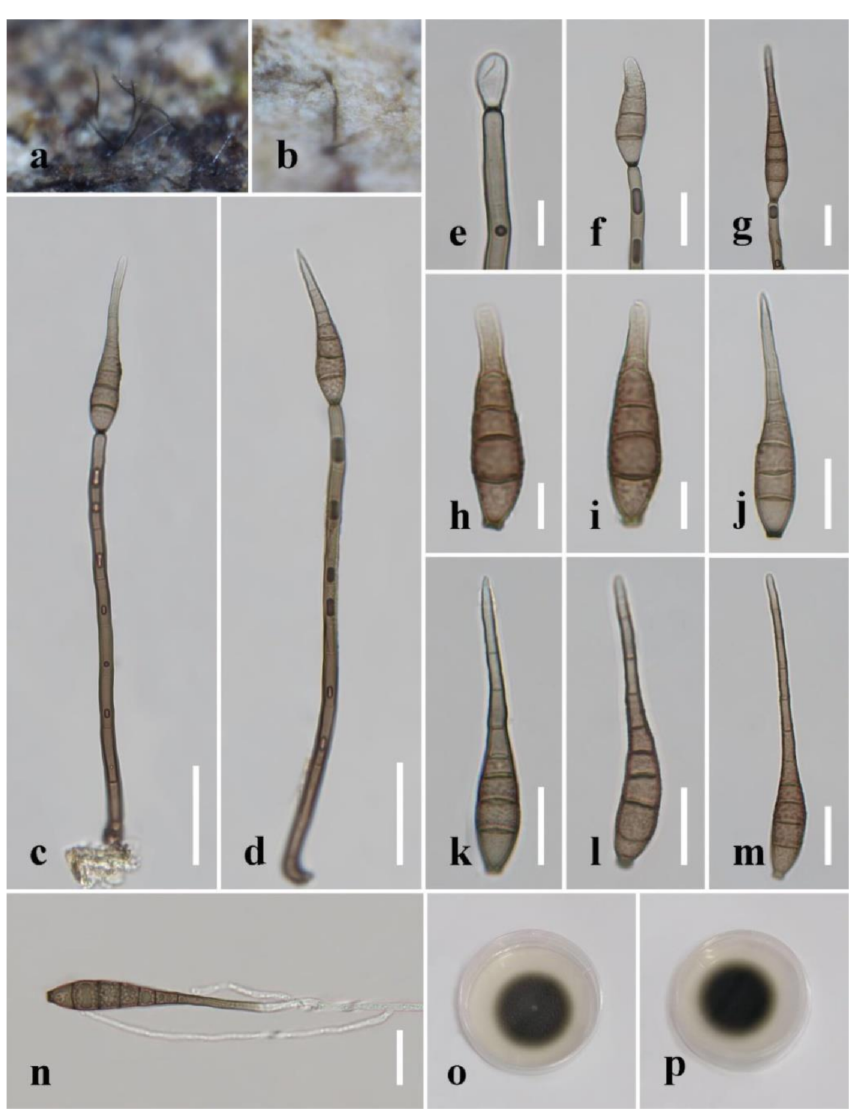
Figure 3. Distoseptispora aqualignicola (HKAS 122184, holotype). ( a , b ) Colonies on natural substrate. ( c , d ) Conidiophores with conidia. ( e – g ) Conidiogenous cells bearing conidia. ( h − m ) Conidia. ( n ) Germinated conidium. ( o ) Colony on PDA (from front). ( p ) Colony on PDA (from reverse). Scale bars: ( c , d ) 30 µ m; ( e , h – i ) 10 µ m; ( f , g , j – n ) 20 µ